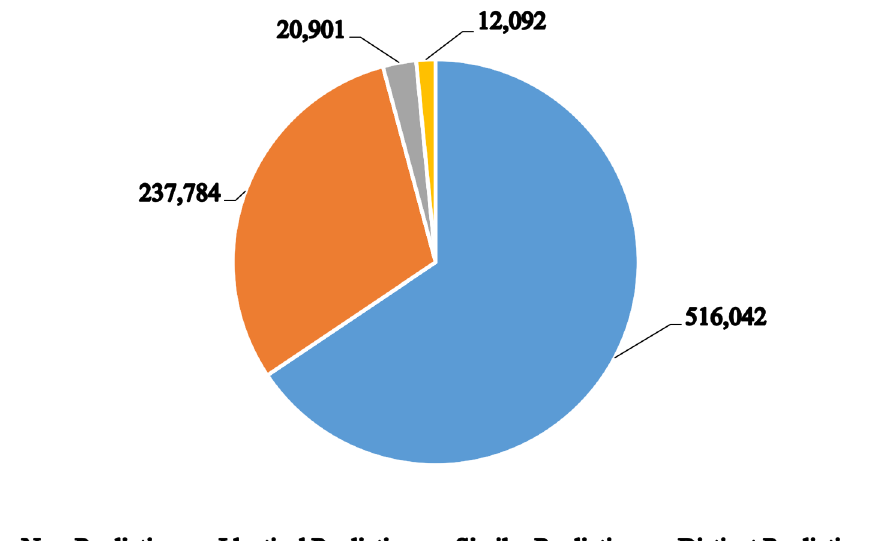
Fig 3. Comparison of predictions applied on UniProtKB/TrEMBL reference proteome prokaryotic entries relative to three main automatic annotation systems present in UniProtKB/TrEMBL which are HAMAP-Rule, SAAS and